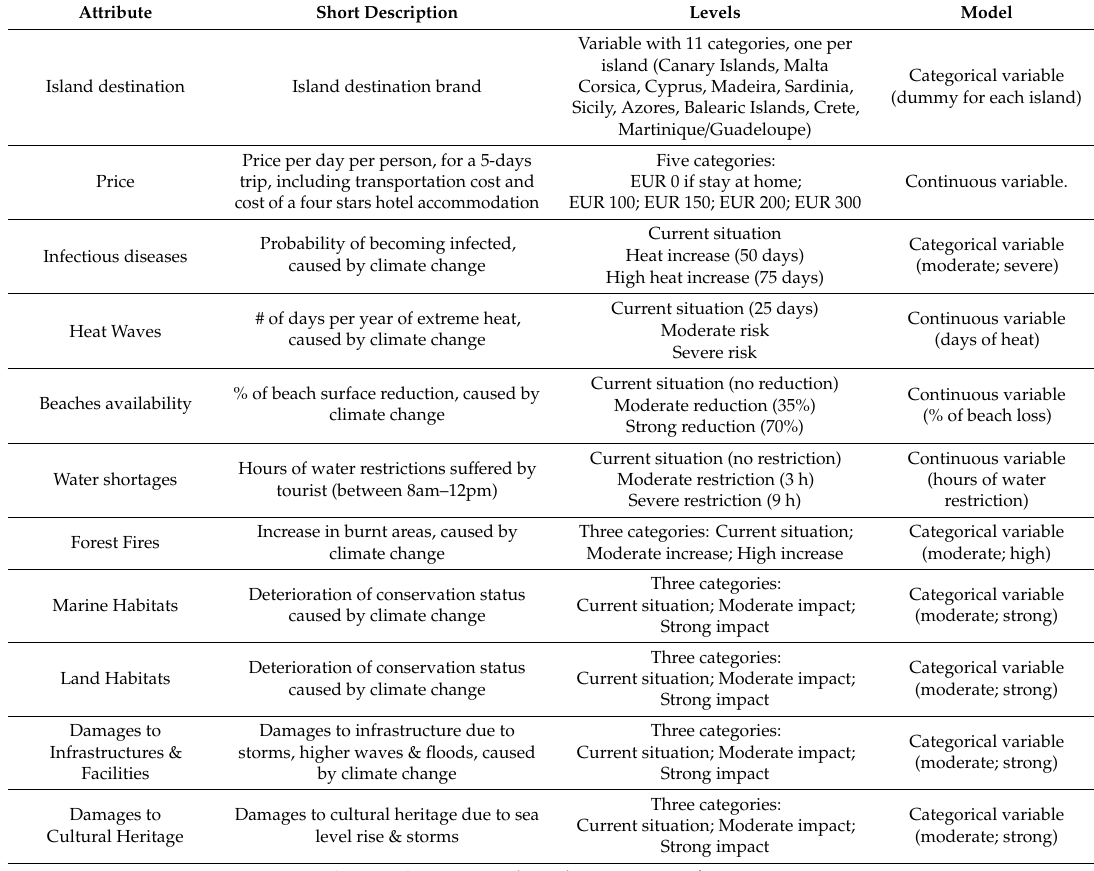
Table 1. Description of attributes considered in the choice experiment.